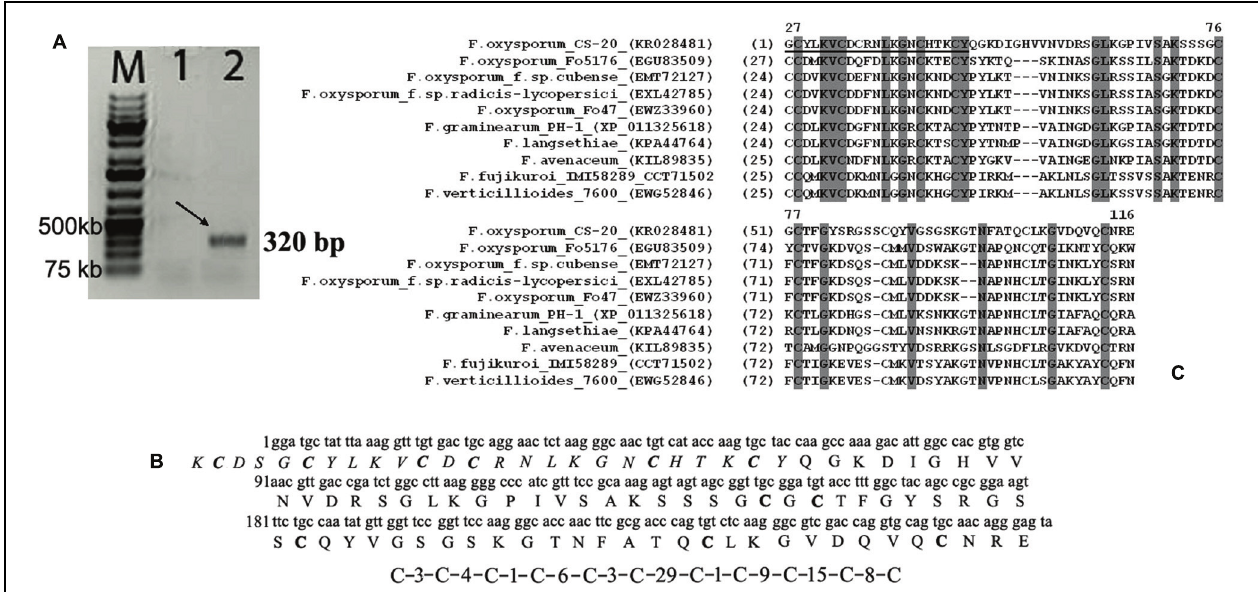
FIGURE 10 | A representative result of electrophoretic analysis of PCR-products amplified by two-step 3 (cid:2) RACE (A); nucleotide and deduced amino acid sequences of the elicitor protein from F. oxysporum CS-20 – CS20EP (B); as well as the alignment of predicted CS20EP amino acid sequence with related sequences deposited in GenBank (C). (A) The arrow indicates the target PCR-product of an estimated size (320 bp) that was amplified after the second 3 (cid:4) RACE round with AdLo-CS20F1 primer pair at different annealing temperatures. Lane 1, 60 ◦ C; line 2, 52 ◦ C; M, GeneRulerTM 1 kb DNA ladder plus. (B) The predicted amino acid sequence of the CS-20 elicitor protein (CS20EP) is shown below the nucleotide sequence (GenBank accession number KR028481). The fifty-five amino acid residues corresponding to those determined by N-terminal sequencing of the protein are marked in italic. Cysteine residues in the amino acid sequence are marked in bold. The cysteine motif is presented under the sequence. (C) Identical amino acid residues in sequences are highlighted by dark-gray boxes. The CS20EP N-terminal sequence determined by Edman’s degradation is underlined.